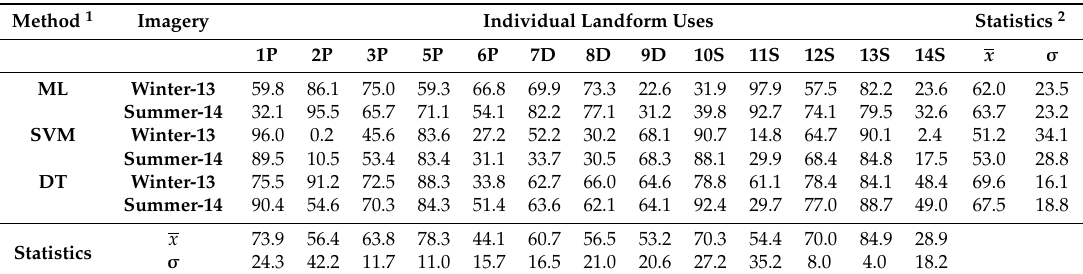
Figure 5. Result of the most accurate landform classifications obtained with the winter-13 image ( a – d ) and the summer-14 image ( a’ – d’ ): ( a ) Maximum Likelihood (ML), ( b ) Support Vector Machine (SVM), ( c ) Decision Tree (DT). Table 6. Producer’s accuracy (%) of the three classifications methods obtained with the best combination of object-based and topographical variables in winter and summer images using Maximum Likelihood, Support Vector Machine and Decision Tree